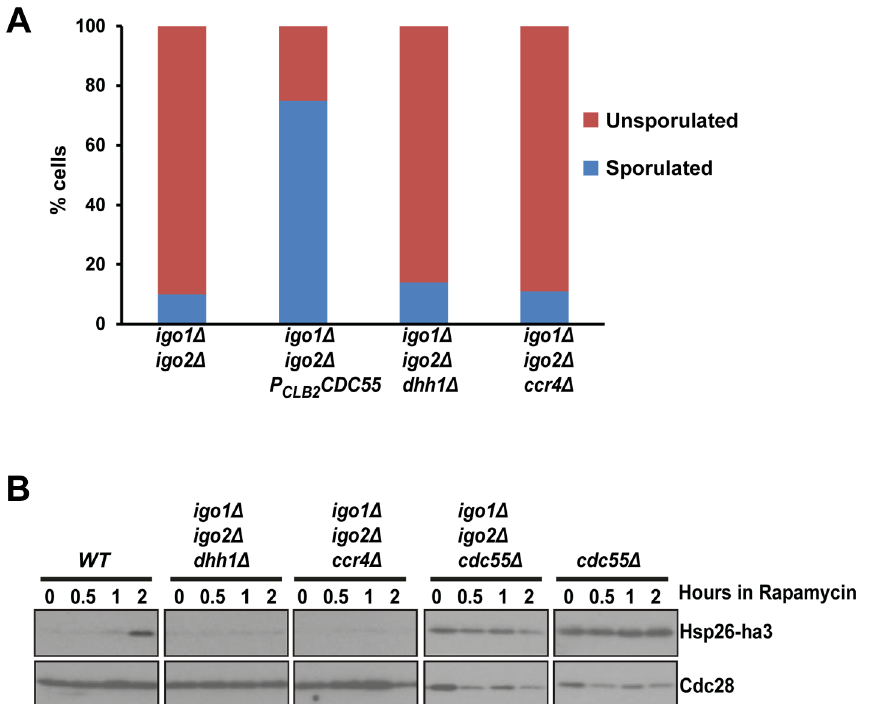
Figure 4. dhh1 D and ccr4 D do not suppress the G 0 - and gametogenesis- entry defects of endosulfine mutant cells. A) Sporulation efficiency of igo1 D igo2 D , igo1 D igo2 D P CLB2 CDC55 , igo1 D igo2 D dhh1 D and igo1 D igo2 D ccr4 D cells was measured (n=200). B) Wild type, igo1 D igo2 D , cdc55 D , igo1 D igo2 D cdc55 D , igo1 D igo2 D dhh1 D and igo1 D igo2 D ccr4 D cells expressing HSP26 - ha3 were grown to log phase at 30 u C. Rapamycin (final concentration 200 ng/ml) was added to the culture and processed as described above. Whole cell extracts were subjected to SDS-PAGE followed by western analysis using anti-HA and anti-Cdc28 antibodies.